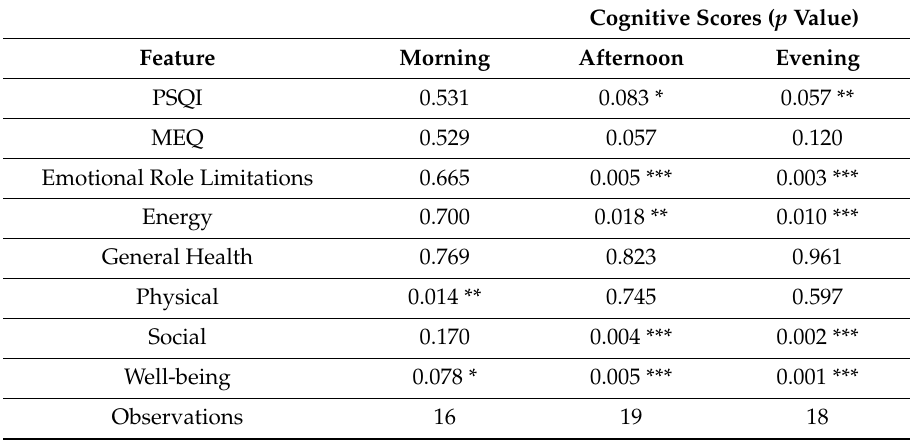
Table 4. In this collection of univariate linear models, the participants’ summary data are the independent variables, and cognitive score is the dependent variable. We present the p values of each univariate regression for cognitive score by timepoint. Please see Supplemental S9–S11 for more statistics related to these regressions. These metrics all represent standardized